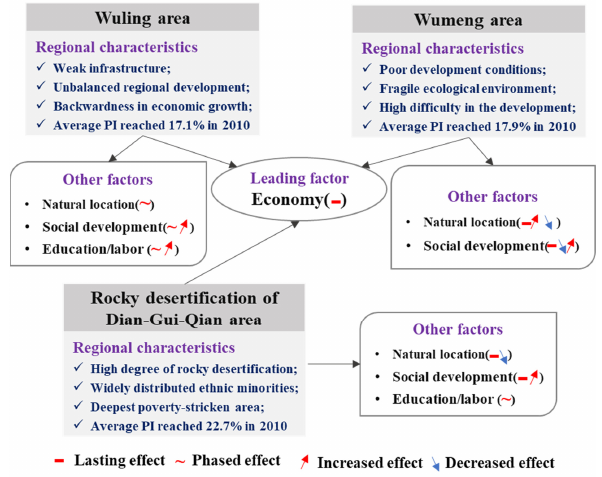
Figure 7. Mechanisms of the spatiotemporal evolution of rural poverty in the three continuously poverty-stricken areas. 5. Conclusions China has reduced absolute poverty and is contemplating a mission shift on consol- idating the achievements of poverty alleviation, preventing regression back to poverty, and targeting relative poverty. In this context, it is important to assess the poverty reduc- tion patterns that have evolved and the influential factors that have helped China reach this point. The main contribution of this paper, based on the spatiotemporal evolution of rural poverty in three continuously poverty-stricken areas in Guizhou Province, is a com- prehensive understanding of the difference between the areas and the influential factors analyzed that impact rural poverty reduction in the different research periods. We conclude that (1) most of the poverty-stricken counties showed a significant downward trend in rural poverty in the periods 2003–2007 and 2011–2017, indicating that those counties had obvious poverty reduction over time; (2) the three continuously pov- erty-stricken areas embodied different characteristics in the different research periods, with degrees of average annual poverty reduction of all research counties between 2.98– 10.09%, 10.60–26.96%, and 11.46–43.19% in 2003–2007, 2008–2010, and 2011–2017, respec- tively, and the spatial heterogeneity of the decreasing poverty in the poverty-stricken counties was obvious from 2011 to 2017; (3) significant differences were observed in the PI average between the three continuously poverty- and nonpoverty-stricken areas except the Wuling and Wumeng areas; and (4) the influencing factors affecting the spatiotem- poral evolution of rural poverty in the three continuously poverty-stricken areas in Gui- zhou Province at the different periods were different, and the degree and effect of each factor had significant spatial differences, which is consistent with the leading influential factors and various influencing factors with regional characteristics. The spatiotemporal evolution of rural poverty and its influential factors in different continuously poverty-stricken areas can deepen our understanding of the mechanism of